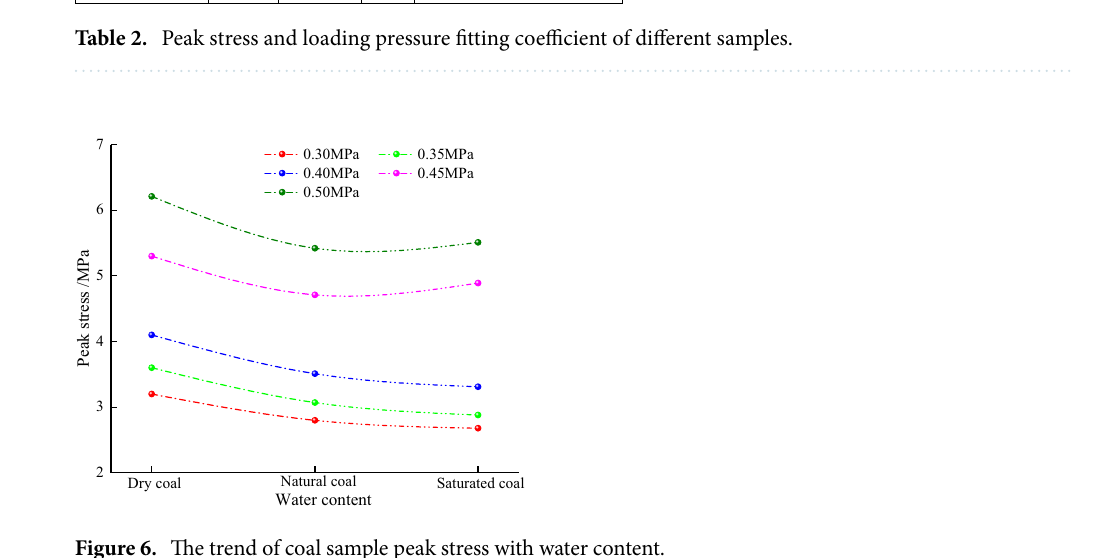
Figure 6. The trend of coal sample peak stress with water